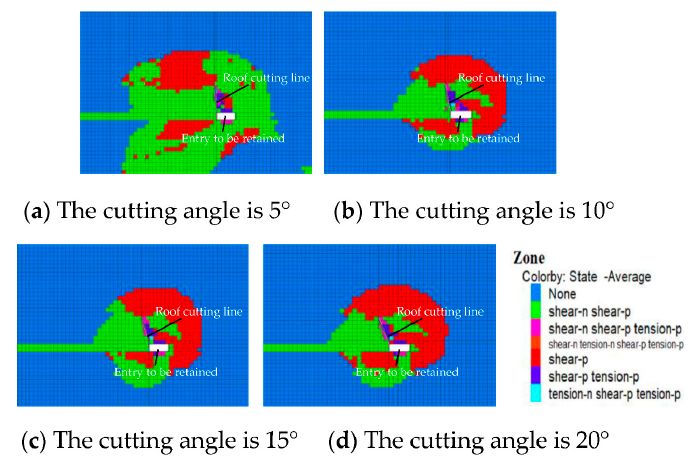
Figure 15. Plastic zone range of the surrounding rock of the roadway under different cutting an- gles.